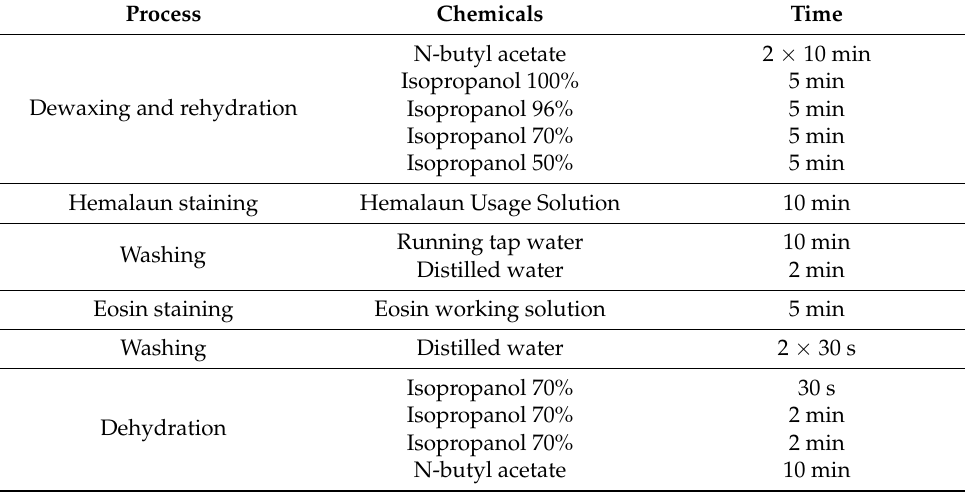
Table 3. Protocol for staining the histological